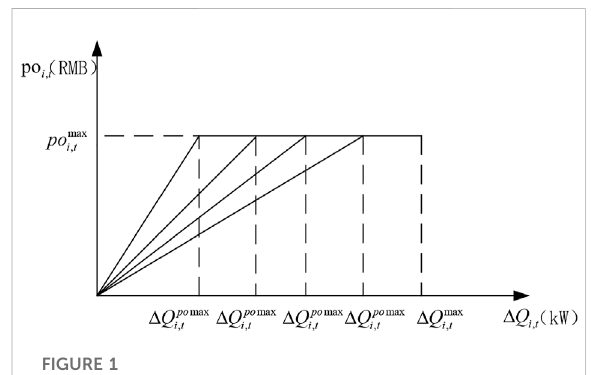
FIGURE 2 Customer base data and customer load